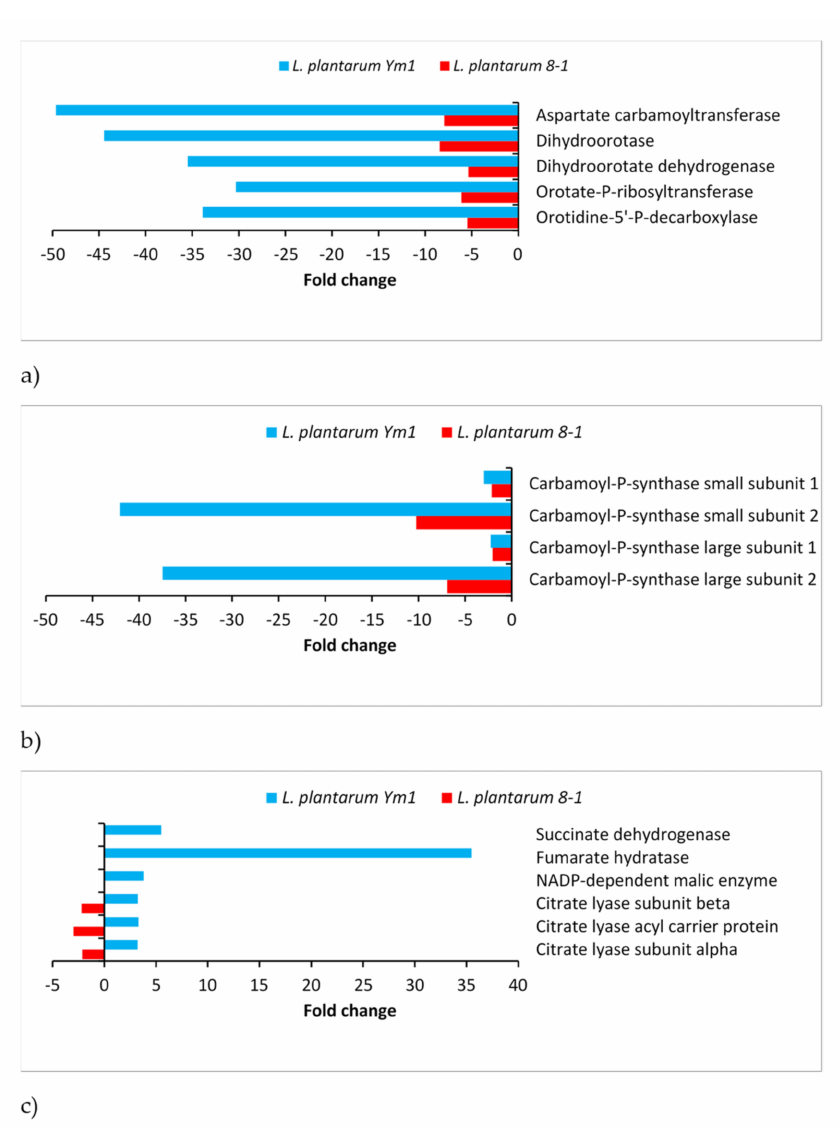
Figure 6. Differentially expressed genes (DEGs) involved in redistribution of citrate, aspartate, and pyruvate in L. plantarum strains Ym1 and 8-1 during butanol stress. ( a ) Enzymes involved in the biosynthesis of pyrimidine nucleotides. ( b ) DEGs encoding carbamoyl phosphate synthase: lp_0527 and lp_0526, small subunit 1 and 2; lp_0526 and lp_2700 ( carB ), large subunit 1 and 2. ( c ) Enzymes involved in the tricarboxylic acid (TCA)-aspartate